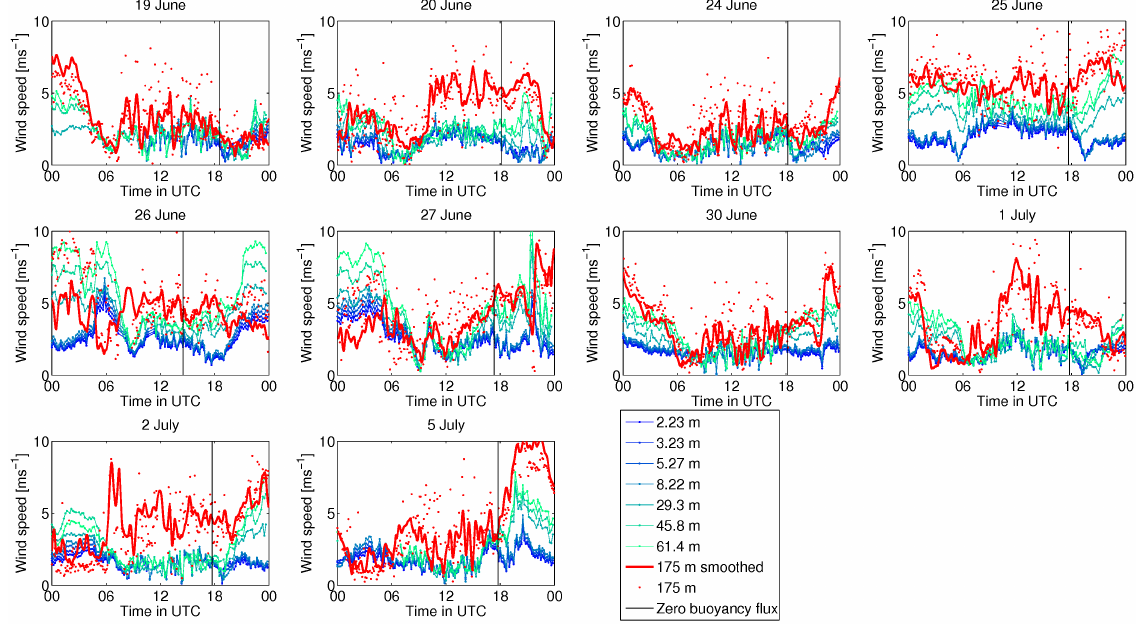
Figure 4. Time series of wind speed with the same color-coding as used in Fig. 3. Here also a 10min height-time smoothed red line is shown for the UHF profiler data at